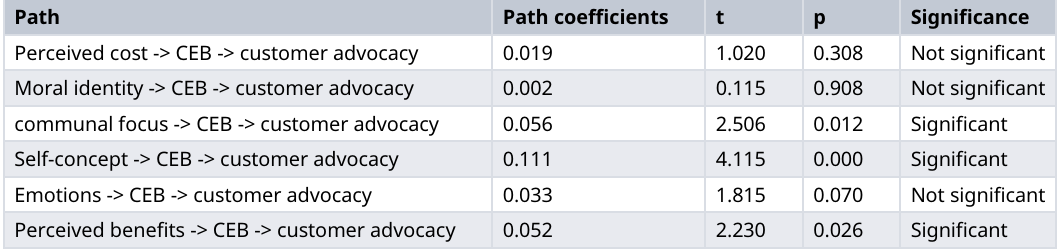
Table 4. Indirect effects of customer predispositions on advocacy behaviours mediator being customer engagement behaviour (CEB). Path Path coefficients t p